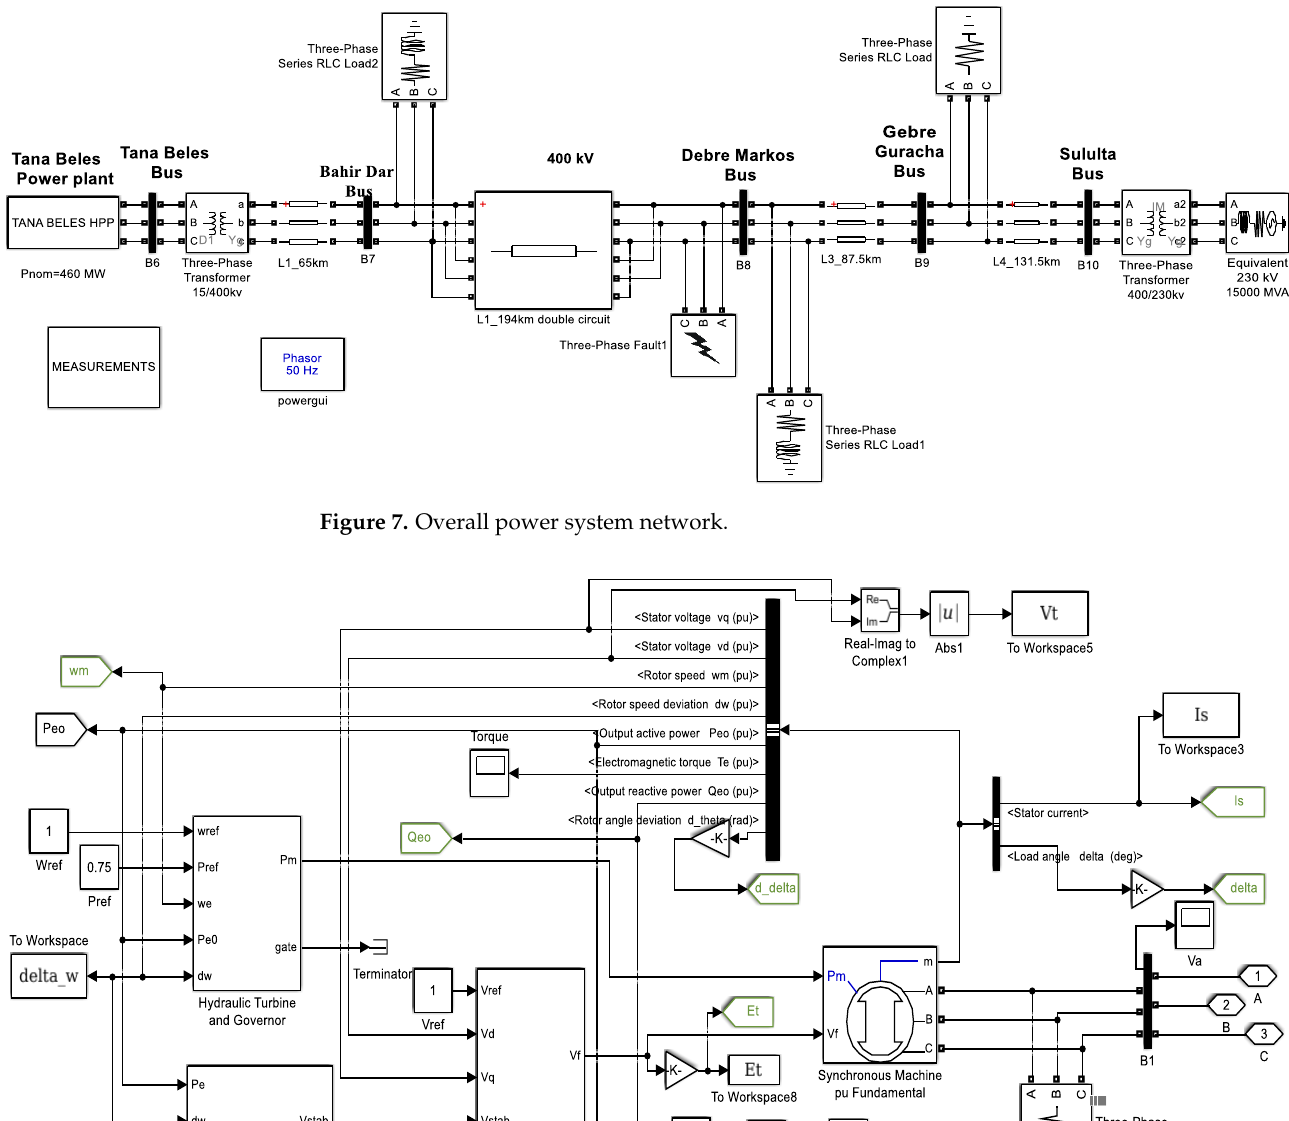
Figure 8. Schematic diagram of dual-input PSS with excitation system .